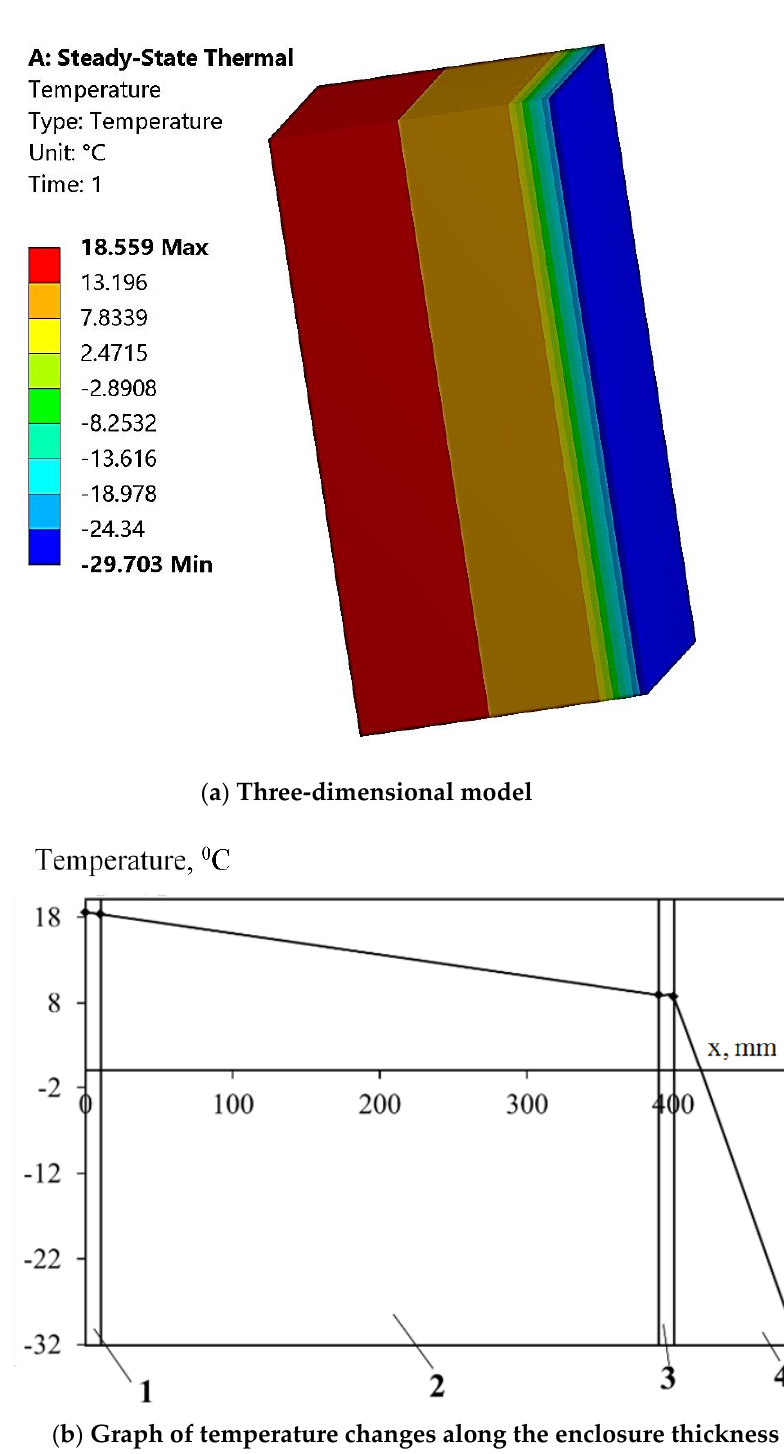
Figure 10. Temperature field in the enclosure at the absolute minimum ambient temperature: ( a ) — three-dimensional model; ( b ) — graph of temperature changes along the enclosure thickness: 1, 3 — cement-sand plaster; 2 — bearing layer from ceramic brick; 4 — insulant — extruded polystyrene foam. The temperature fields in the enclosure at the maximum ambient temperature, at the average temperature of the coldest five-day period with a probability of 0.92 and at the average temperature of April were calculated by a similar method, the results of which are presented in Table 5. Table 5. Thermal resistance of the enclosure according to Figure 1.